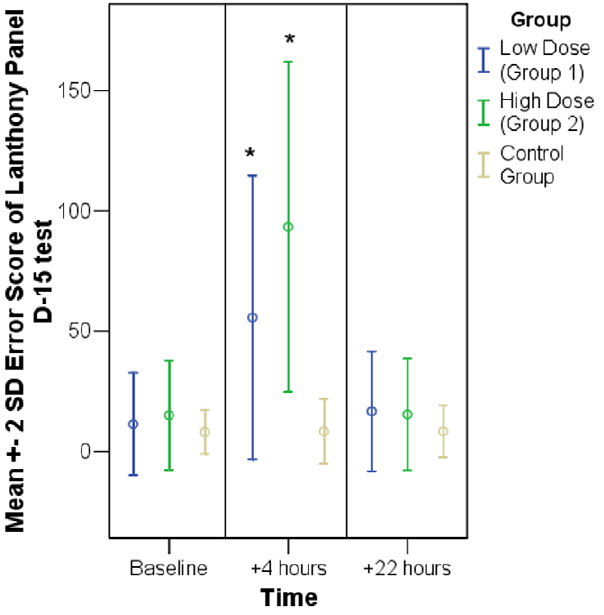
Figure 3. Rod threshold. Time course of mean rod threshold + / 2 2 * standard deviation for both eyes of all probands. Significant changes (marked with an asterisk) compared to baseline occured in both treated groups after 4 hours and also after 22 hours in group 2.